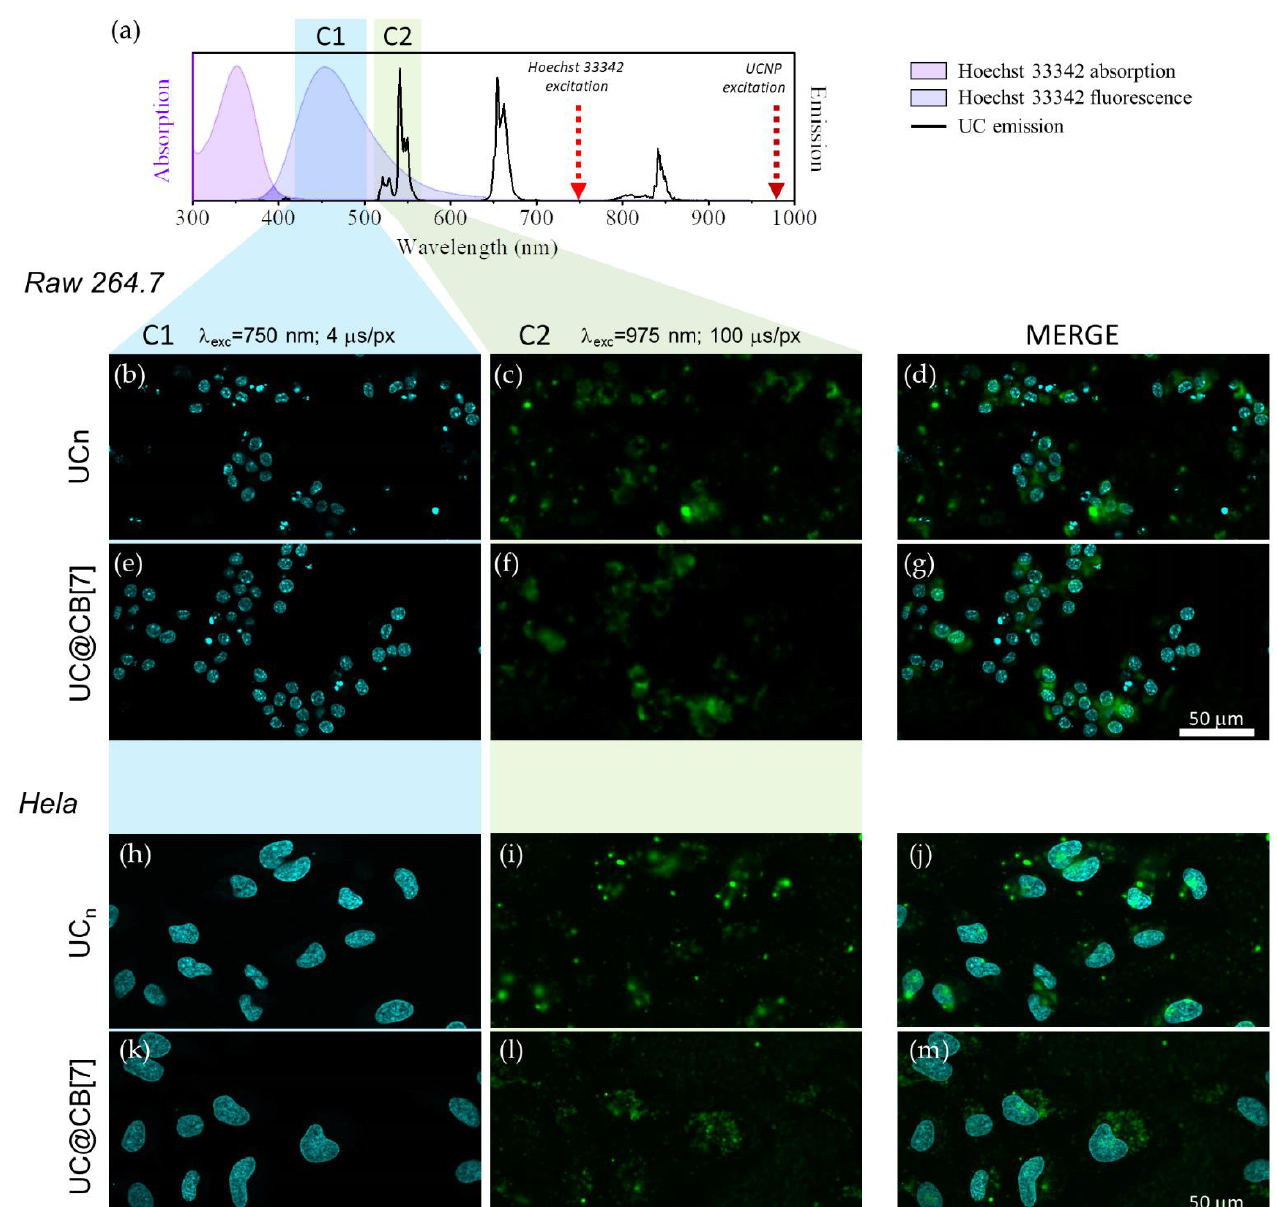
Figure 6. ( a ) Absorption (pink area) and fluorescence (purple area) of Hoechst 33342, emission of UC n dispersion in DMSO (black line) together with the wavelength used to excite the dye/UCNP (arrows) and the microscope detection channels (coloured rectangles). ( b – g ) microscope images of RAW 264.7 cells exposed to UC n and UC@CB[7]. ( h – m ) microscope images of HeLa cells exposed to UC n and UC@CB[7]. Left column shows the fluorescence signal of Hoechst 33342 ( λ ex = 750 nm, dwell time: 4 µ s/pixel, detection channel: C1) central column shows the 520/540 nm Er 3+ upconversion emission ( λ ex = 975 nm, dwell time: 100 µ s/pixel, detection channel: C2) and right column is a composite of the in line previous images. 50 µ m scale bar applies for all images.